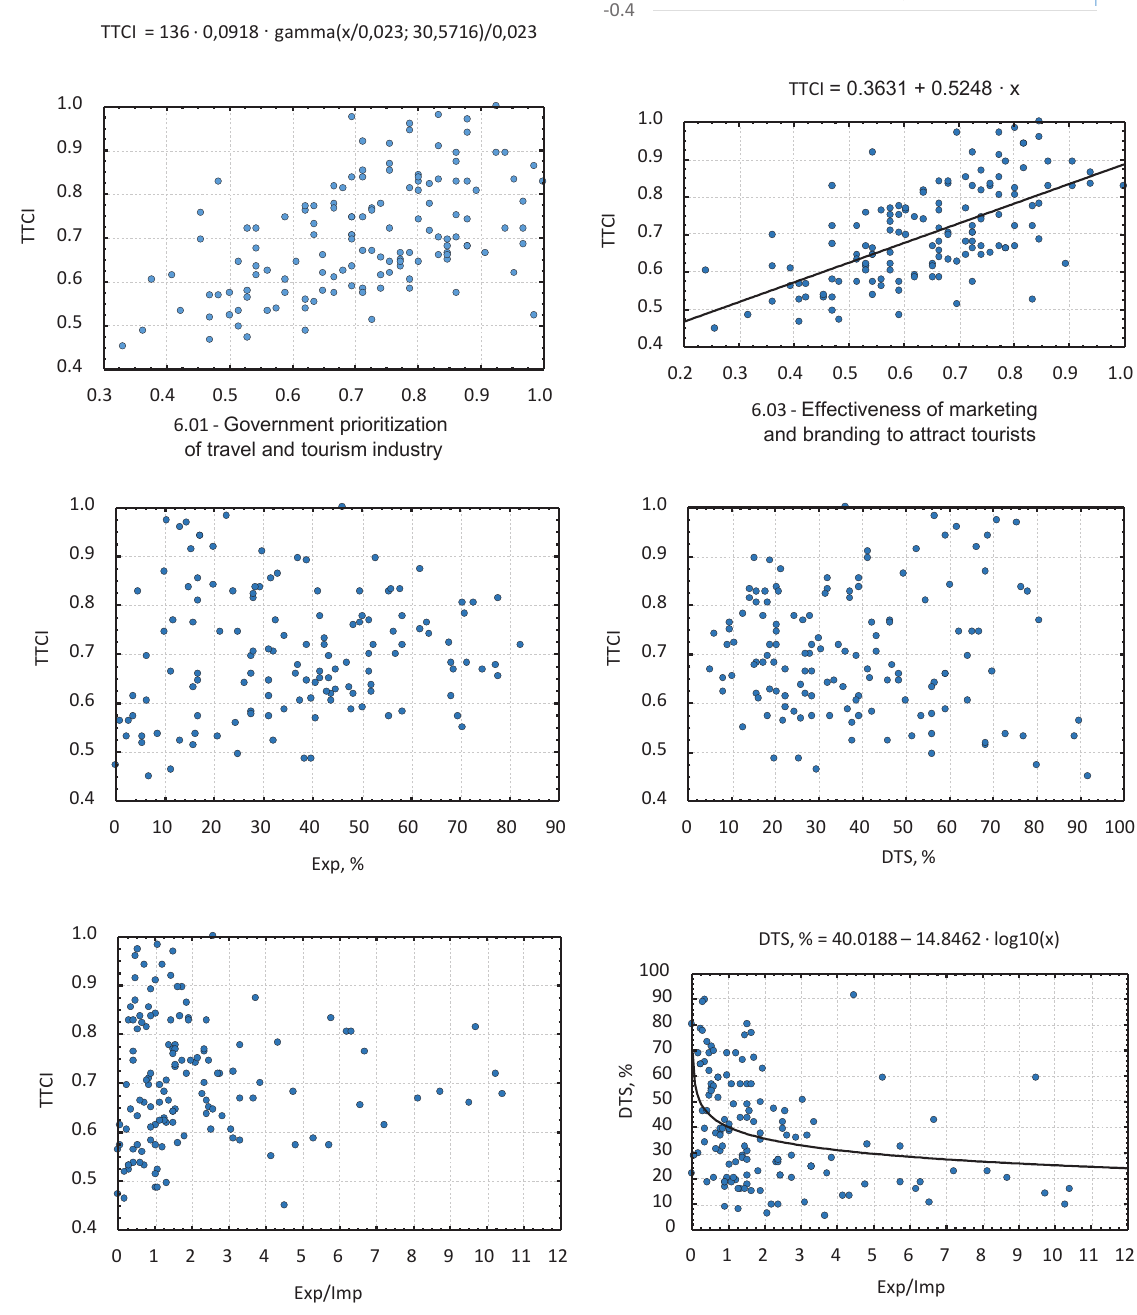
Figure 1. Correlation-regression analysis